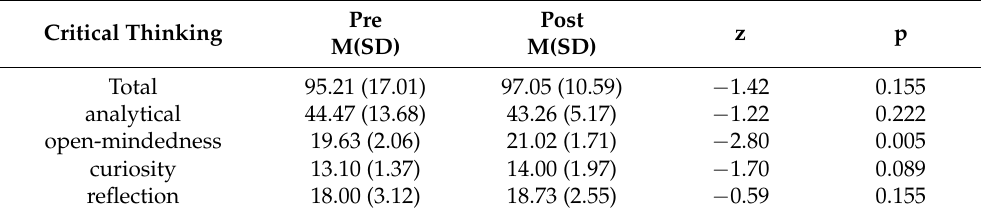
Table 1. Critical thinking about differences in various aspects pre-post psychiatric practice ( n = 19).